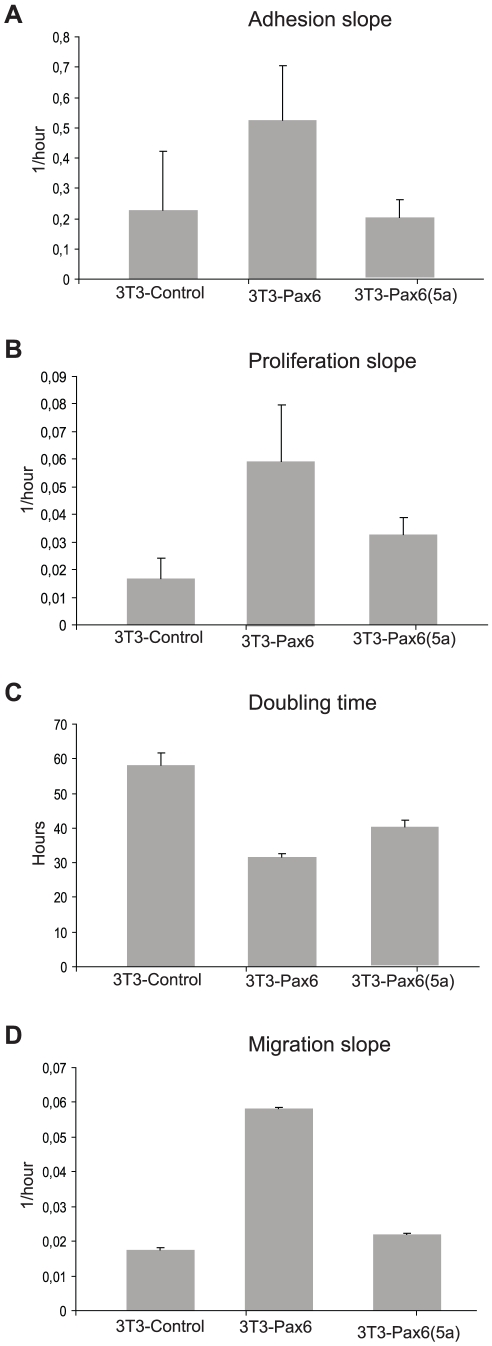
Pax6 expressing FlpIn-3T3 cells have higher proliferation and higher migration capacity compared to FlpIn-3T3 control cells and Pax6(5a) expressing cells.Control, Pax6 and Pax6(5a) cells were seeded in xCELLigence (Roche) proliferation plates, cells were left on the bench for 1 hr before the plates were put in the xCELLigence machine for measurements for 24 hrs. The measured values were used to calculate the (A) adhesion slope, (B) proliferation slope and (C) doubling time. For adhesion and proliferation slope analyses the mean and standard deviation of three independent experiments are shown. The doubling time analysis shows one representative experiment out of three, because absolute values were changing from experiment to experiment probably due to fluctuations in cell condition. However, described pattern of increased proliferation (Pax6>Pax6(5a)>control) was consistent in all experiments. Each experiment was done in triplicates (A–C). xCELLigence migration plates were used to measure the migration, and to calculate the migration slope (D). One representative experiment out of 3 is shown.